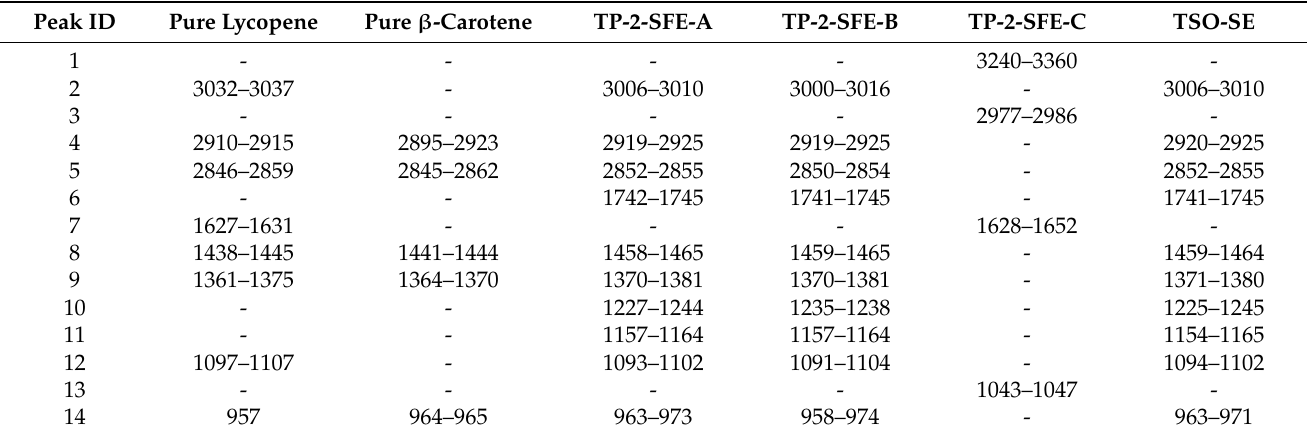
Table 4. FT–IR spectral bands identified for pure carotenoids and tomato